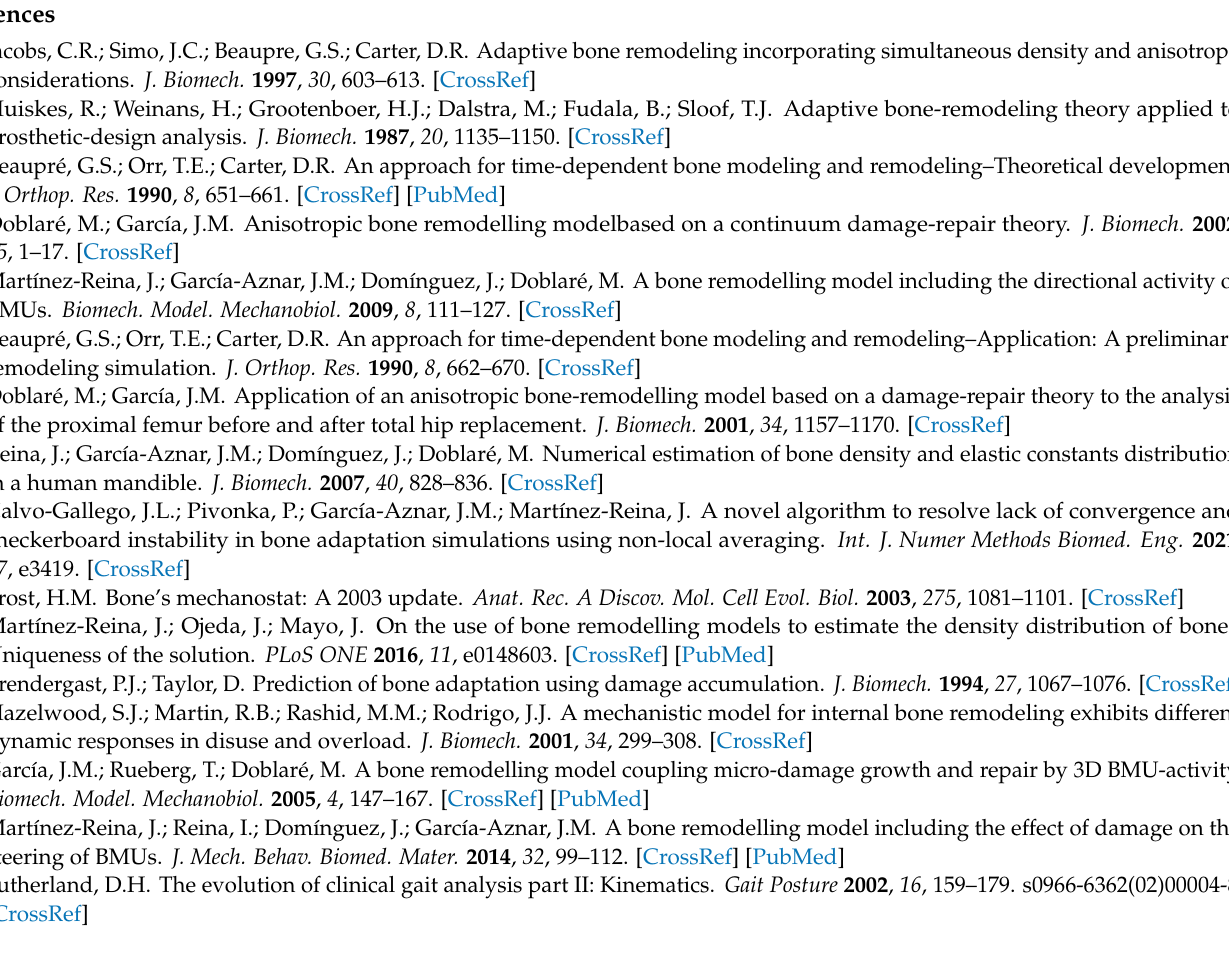
Figure A2. Temporal evolution of the HJF and KJF throughout the gait cycle. AP: Antero-posterior. CC: Cranio-caudal. LM: Lateral-medial. BW: Body